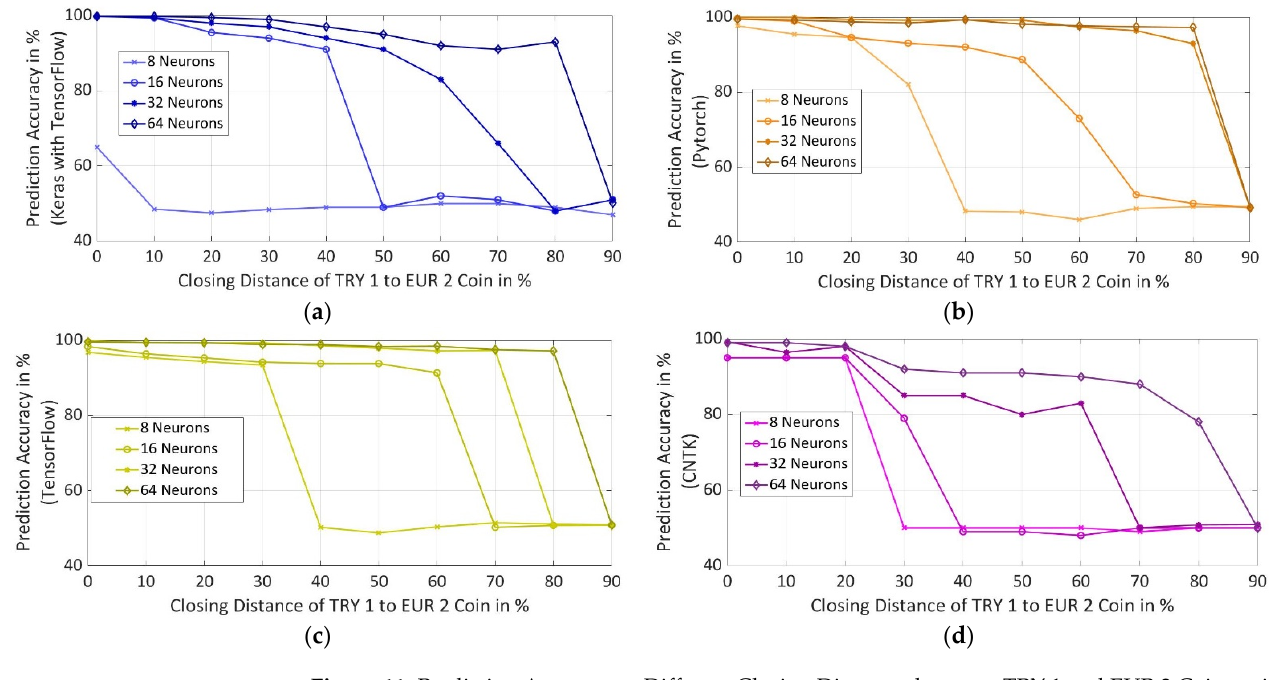
Figure 11. Prediction Accuracy at Different Closing Distances between TRY 1 and EUR 2 Coins using Different Number of Neurons in Hidden Layers for Different Frameworks: ( a ) Keras with TensorFlow Backend ( b ) Pytorch ( c ) TensorFlow ( d ) CNTK.